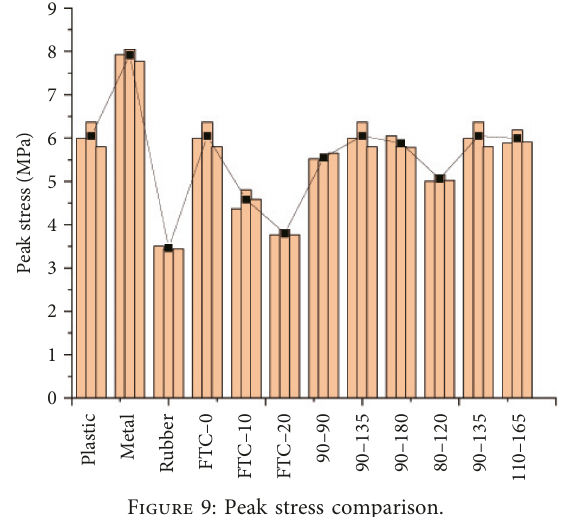
Figure 9: Peak stress comparison.